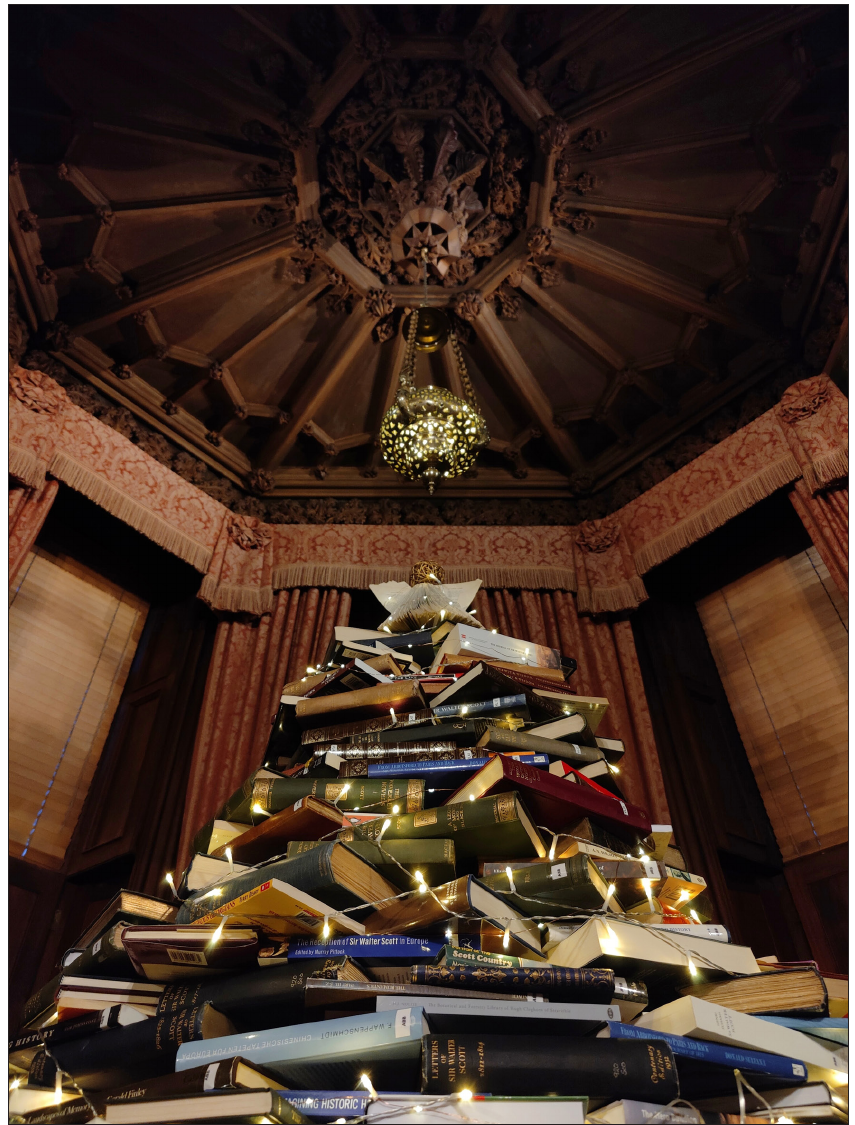
Fig. 3 : The Christmas book tree themed around Scott’s life and works. Photo: Abbotsford